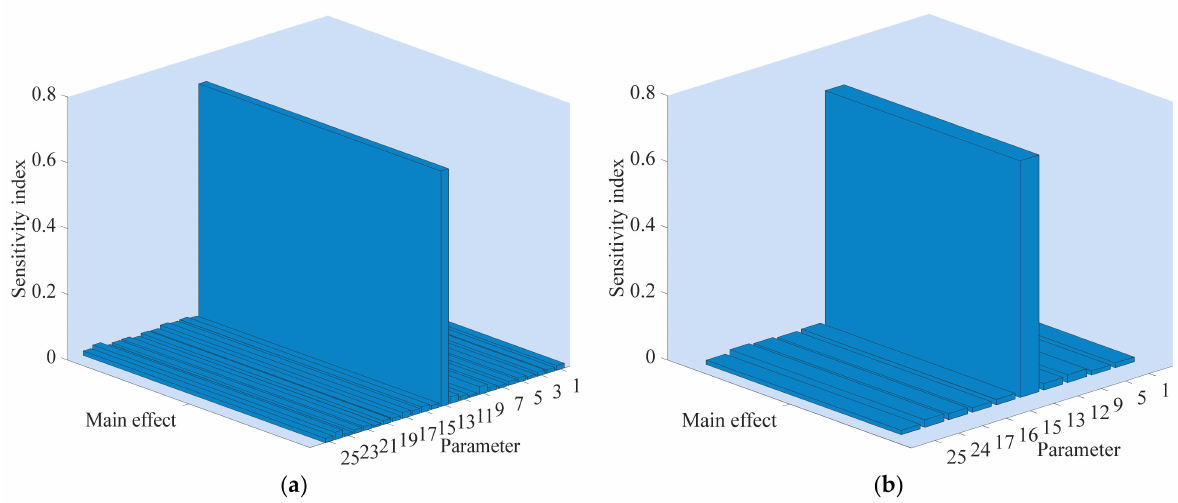
Figure 18. The sensitivity index of parameters of the peak time of the angular velocity. ( a ) The sensitivity index of 25 parameters; ( b ) The sensitivity index of the top 10 parameters. The numbers 1 to 25 represent symbols T , Kp , b p , K d , A t , D t , f p , q nl , T 0 , T d0 , T d00 , T q00 , H , F , K a , R s , L ls , R r , L lr , L m , H 1 , F 1 , WS , Ncellm12 and I r , respectively. For the physical meaning and definitions of these parameters, see Appendix